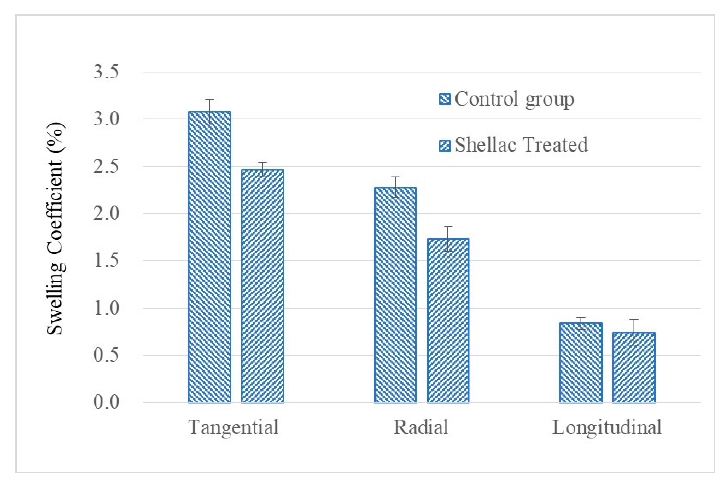
Figure 1. Swelling coe ffi cients in di ff erent directions for the control and shellac-treated groups.